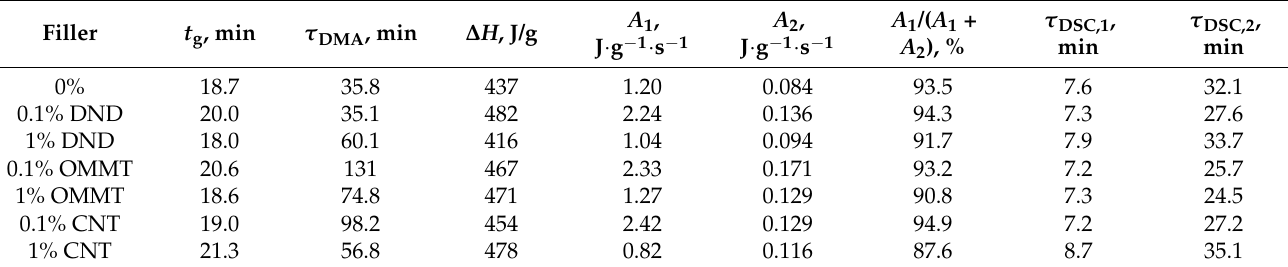
Table 1. Effect of fillers on the curing characteristics of epoxy